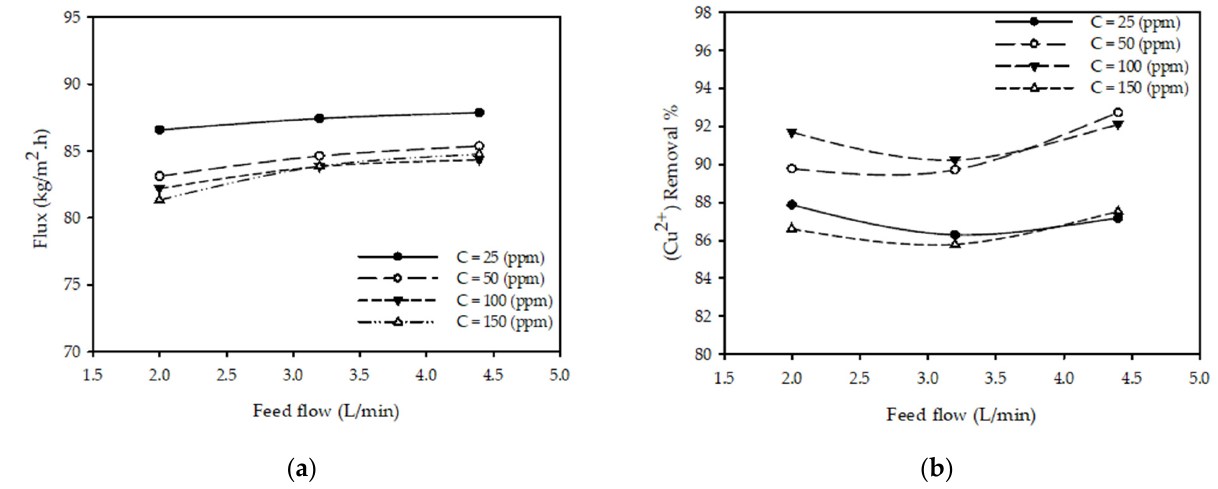
Figure 5. Effect of flow rate on ( a ) permeate flux ( b ) (Cu 2+ ) removal % at different feed concentrations for constant pressure 20 (bar) and feed temperature 25 °C.